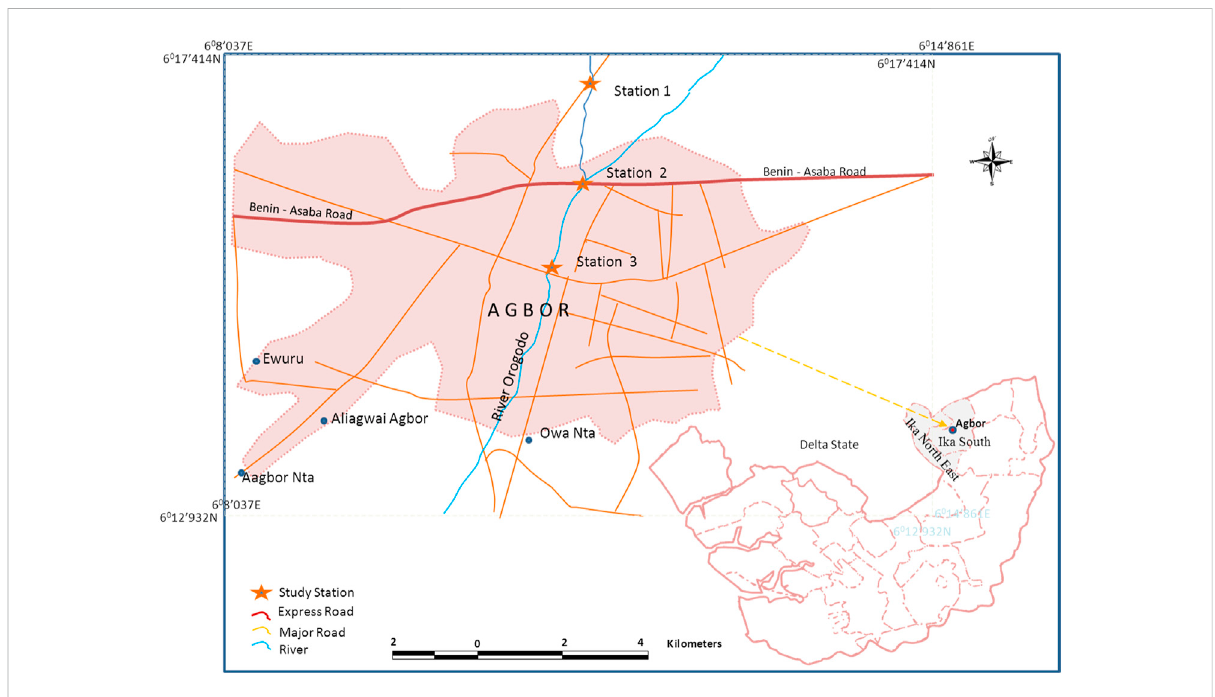
FIGURE 1 Map of the study area showing the sampled